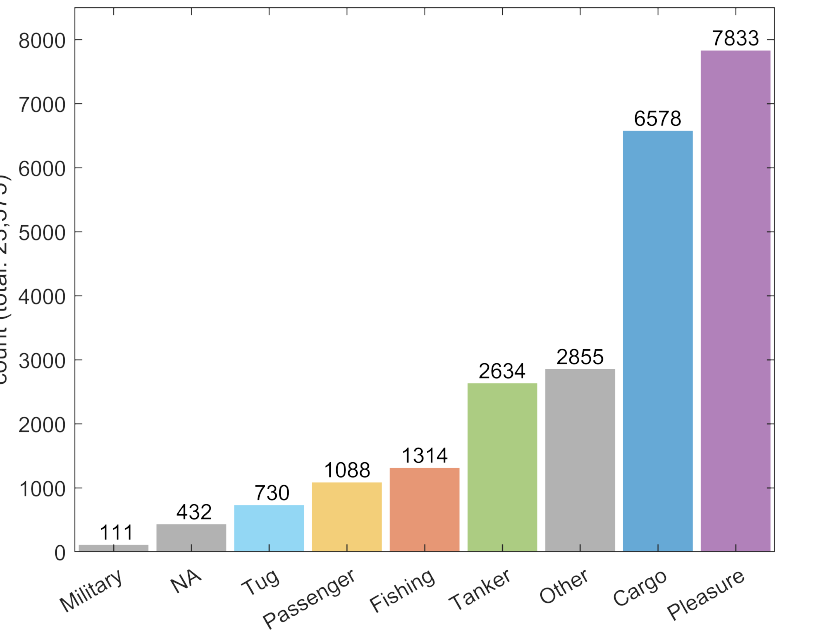
Figure 3. Training data ( AIS C ) ship type distribution.